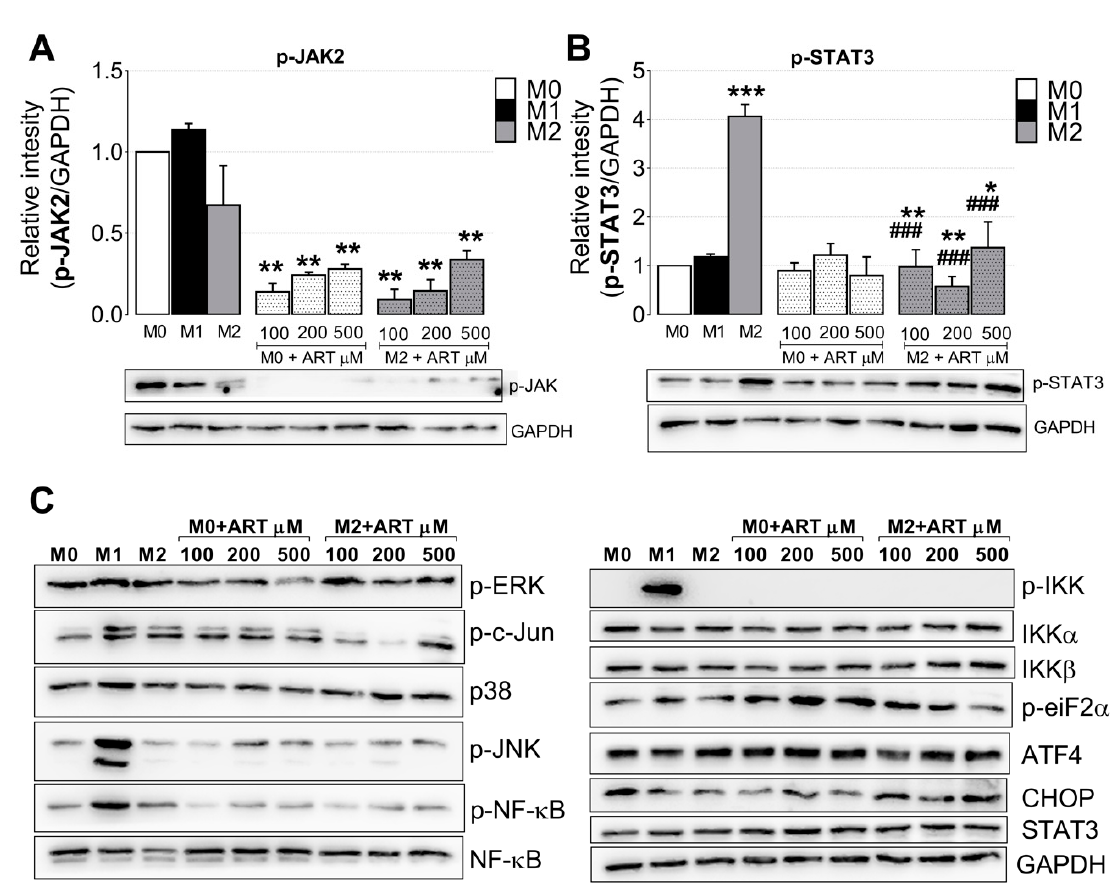
Figure 5. ART downregulates JAK2/STAT3 pathway in IL-4 treated human primary monocytes. Monocytes were treated with increasing doses of ART (100, 200, and 500 µ M) for 15 min as in the prevention protocol, in the presence or not of IL-4. Protein was extracted with RIPA buffer and immunoblotted with anti-p-JAK2 ( A ), anti-p-STAT3 ( B ) antibodies, and submitted to densitometry. ( C ) Immunoblotting of the same extracts using antibodies against proteins of the MAPK, endoplasmic reticulum stress, and NF-kB pathway. Data of the densitometric analysis represent mean ± SEM of at least three independent experiments performed in triplicate. Data were analyzed by ANOVA followed by Tukey post hoc. *, ** and ***, significantly different from control M0 cells (white bar). ###, significantly different from M2 cells (grey bar). Images of immunoblotting are representative of one